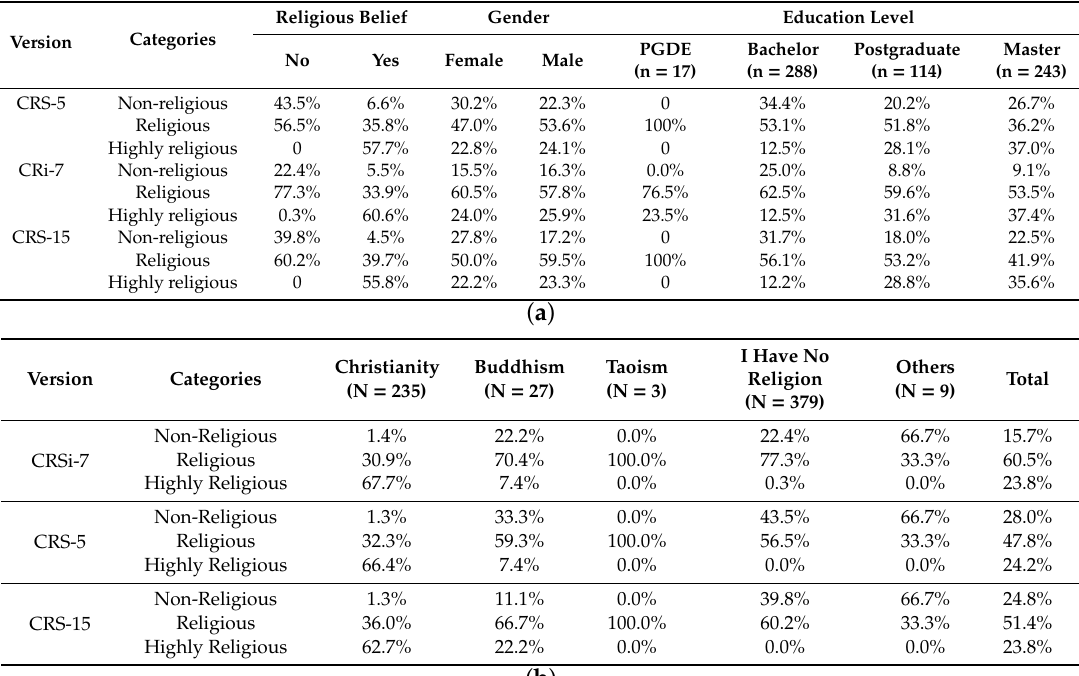
Table A6. ( a ) CRS categorization of religious belief, gender, and educational levels. ( b ) CRS categorization between religions.